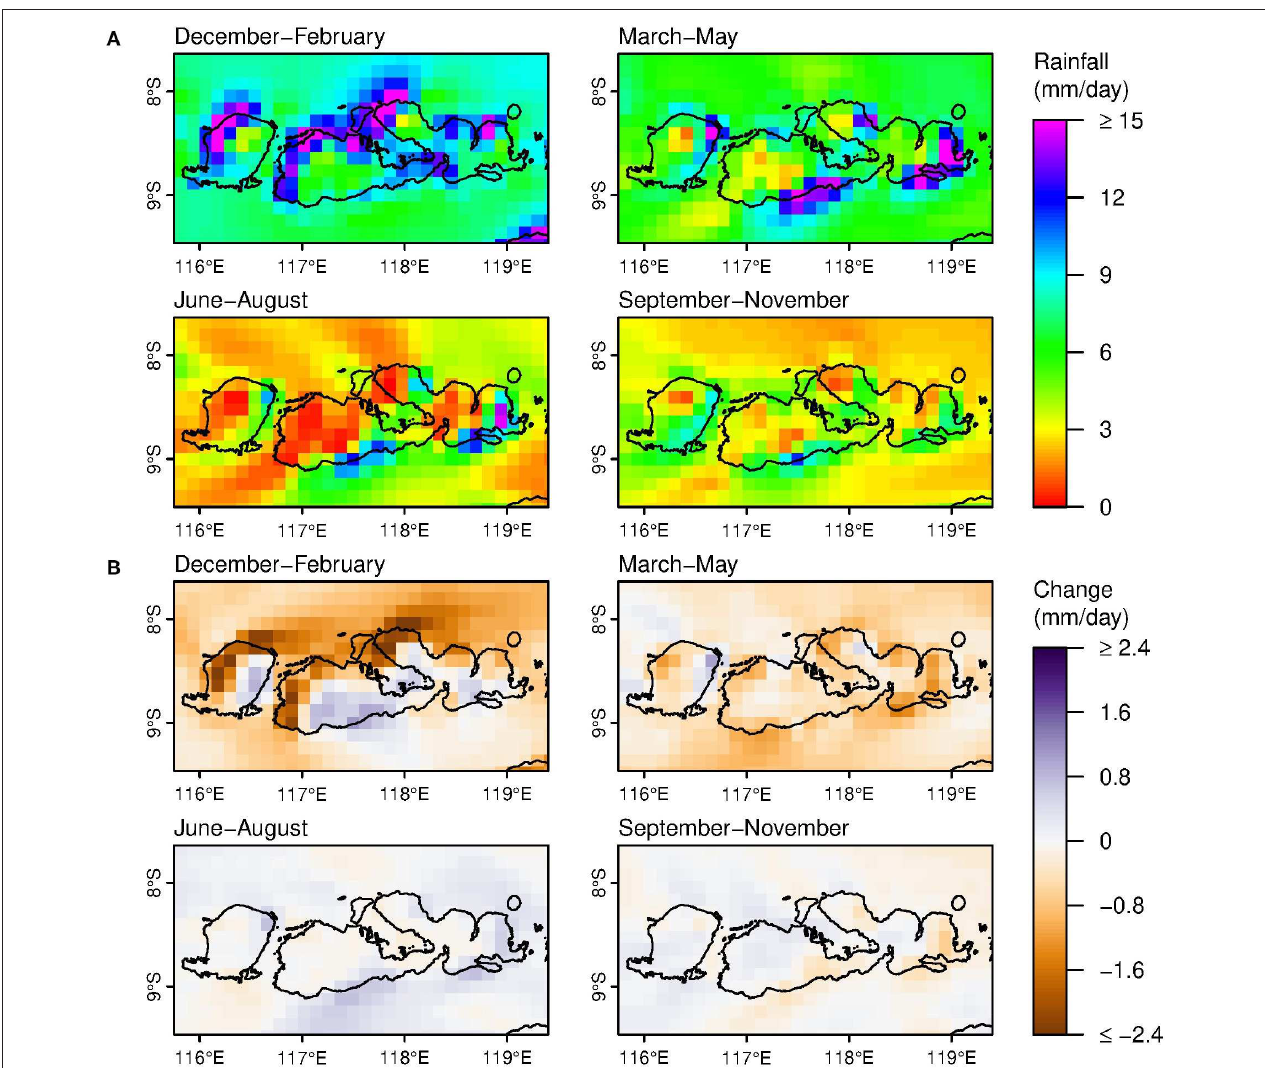
FIGURE 2 | Downscaled seasonal rainfall projections for Nusa Tenggara Barat in 2060 at 14km resolution, showing (A) projected rainfall and (B) changes relative to 1990. Simulations are for the global SRES A2 emissions scenario (see McGregor et al., 2016 for details).